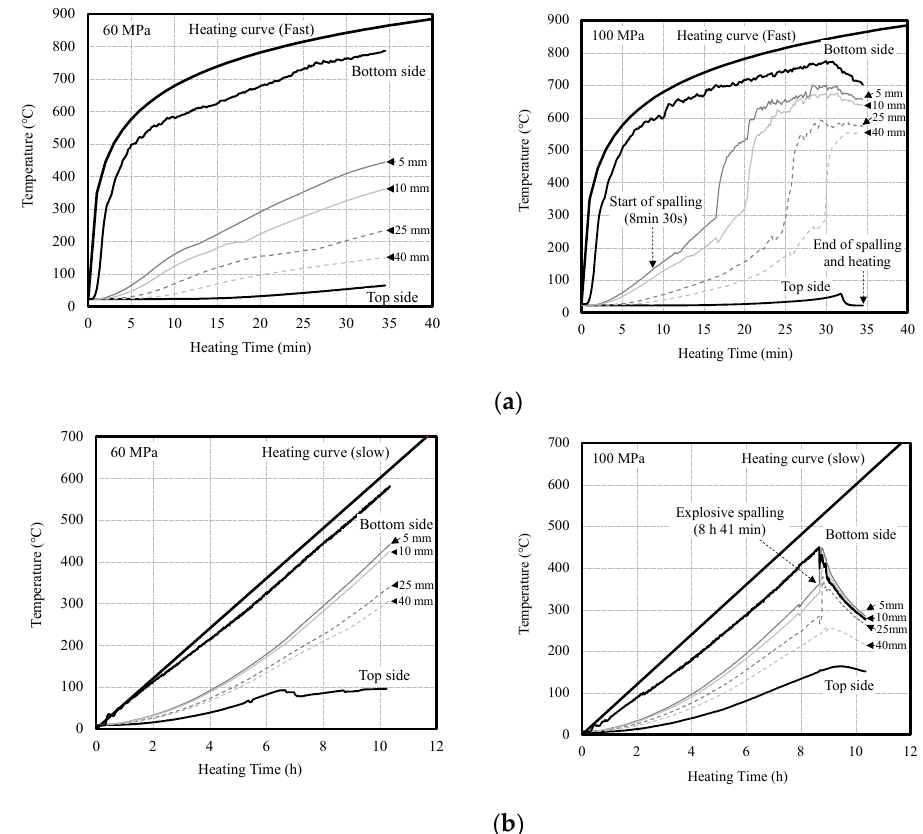
Figure 6. Internal temperature of concrete according to heating rate. ( a ) Fast heating (ISO-824). ( b ) Slow heating (1 °C/min).